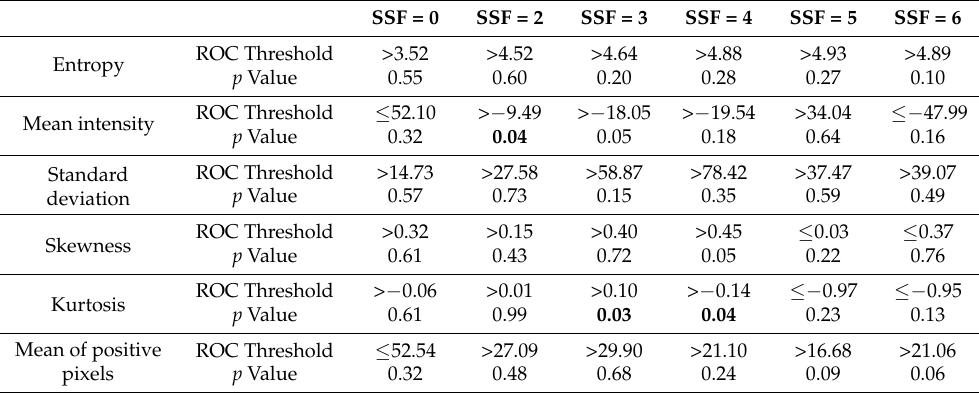
Table 4. ROC and Kaplan-Meier analysis for baseline texture parameters at different scale values.